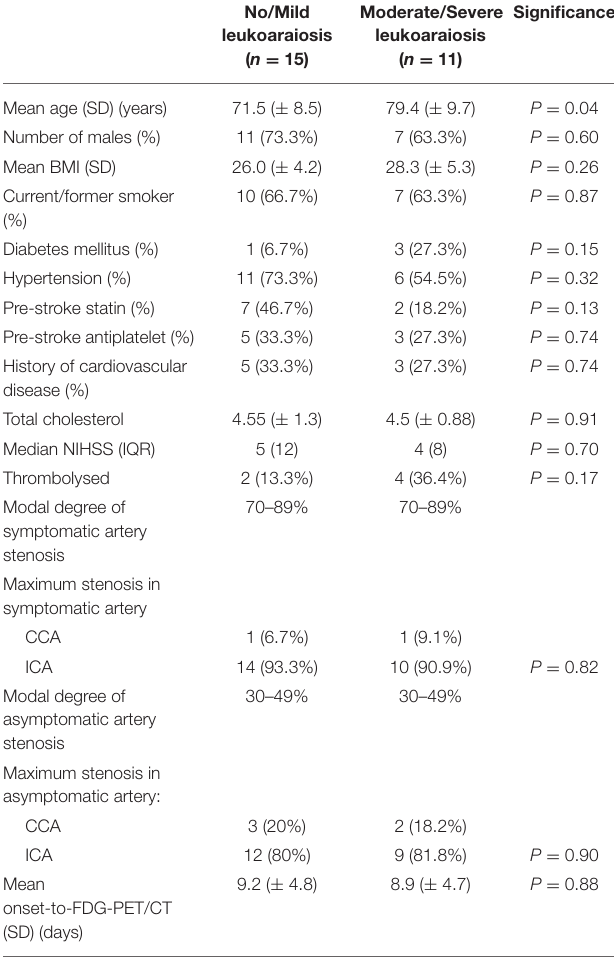
TABLE 2 | Comparison of dichotomized groups of small vessel disease